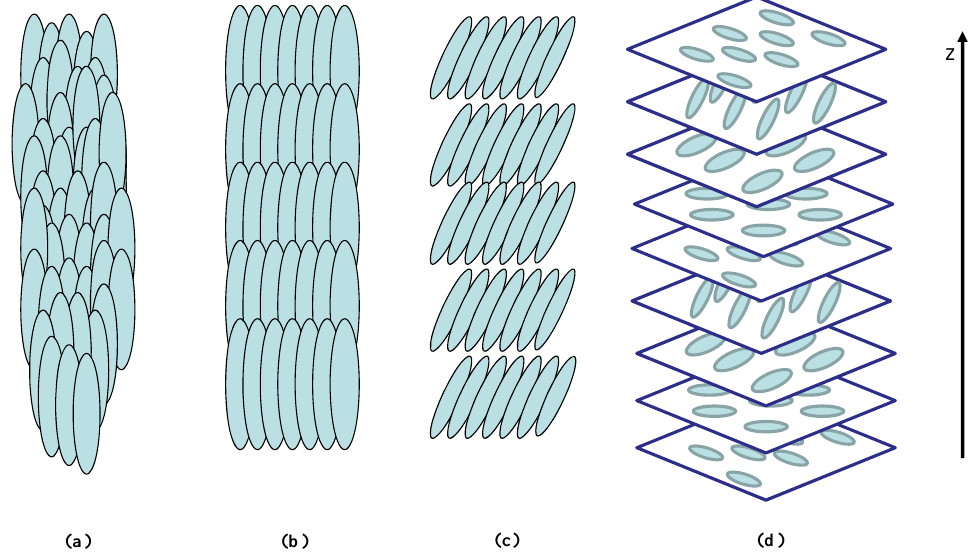
Figure 3. Schematic representation of different Liquid crystal (LC) phases, ( a )